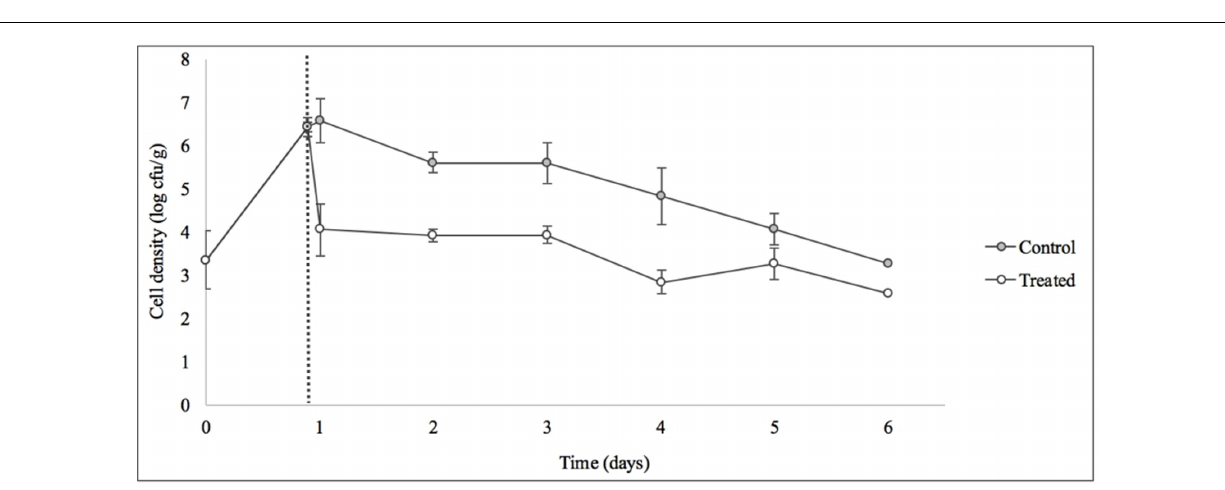
FIGURE 8 | In vitro analysis of S. Typhimurium inhibition by phages SI1, SS4, SF1, and SS1 at (A) MOI = 1, (B) MOI = 10, and (C) MOI = 100. Data shown are the mean of three replicates ± SD.